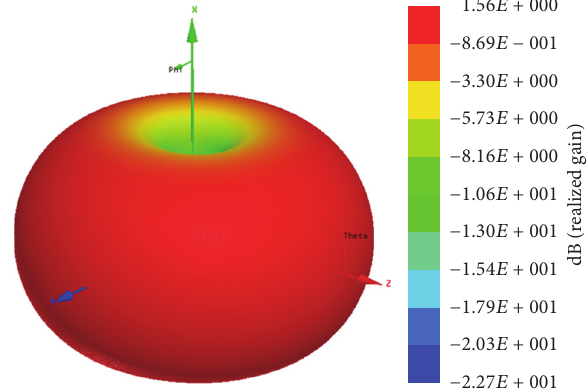
Figure 4: Simulated 3D radiation patterns of the proposed antenna at 433 MHz.